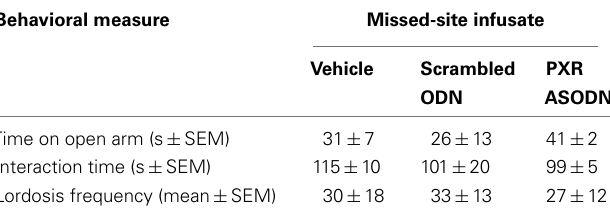
Table 2 | Data from missed-site controls do not demonstrate reliable difference between rats infused with scrambled oligodeoxynucleotides (ODN) versus antisense ODN in elevated plus maze (open arm time), social interaction (interaction time), or paced mating (lordosis